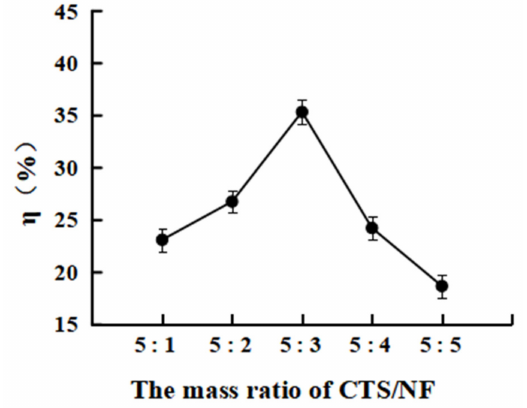
Figure 5. Effect of the mass ratio of M CTS /M NF on the grafting